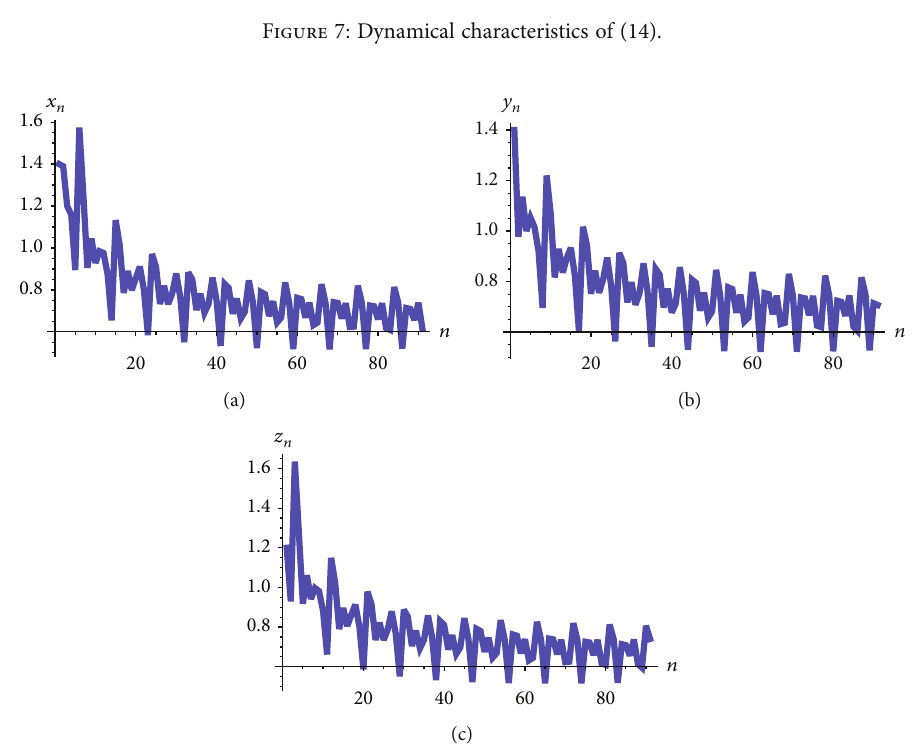
Figure 7: Dynamical characteristics of (14).